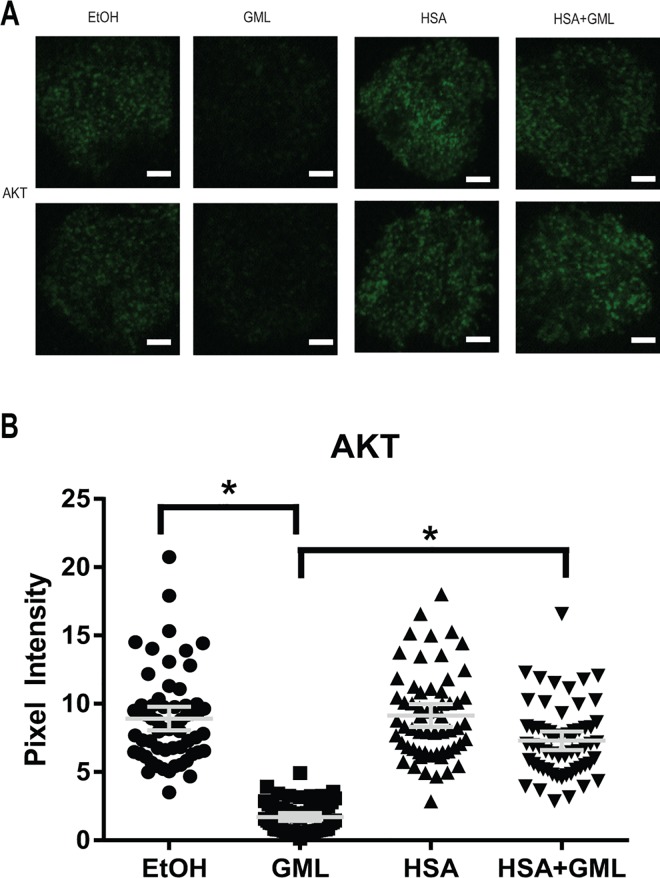
HSA rescues AKT microcluster formation in GML treated cells.(A). APBTs treated with 0.1% ethanol or 10 μg/ml GML in serum free media as well as 0.1% ethanol or 10 μg/ml GML in 1% HSA were stimulated by plate bound anti-CD3 (2 μg/ml) in glass covered chamber slides. They were then fixed, permeabilized, stained with antibody specific for total AKT, and imaged using TIRF microscopy. White bar scale indicates 4 μm in length. (B). Pixel intensities of median axis of each cell in images obtained in (A) were quantified and averaged using ImageJ. Scatter plot distributions with 95% confidence intervals of 60 cells from 3 independent experiments are shown. * denotes p<0.05 in Student t’s test comparing the identified samples.